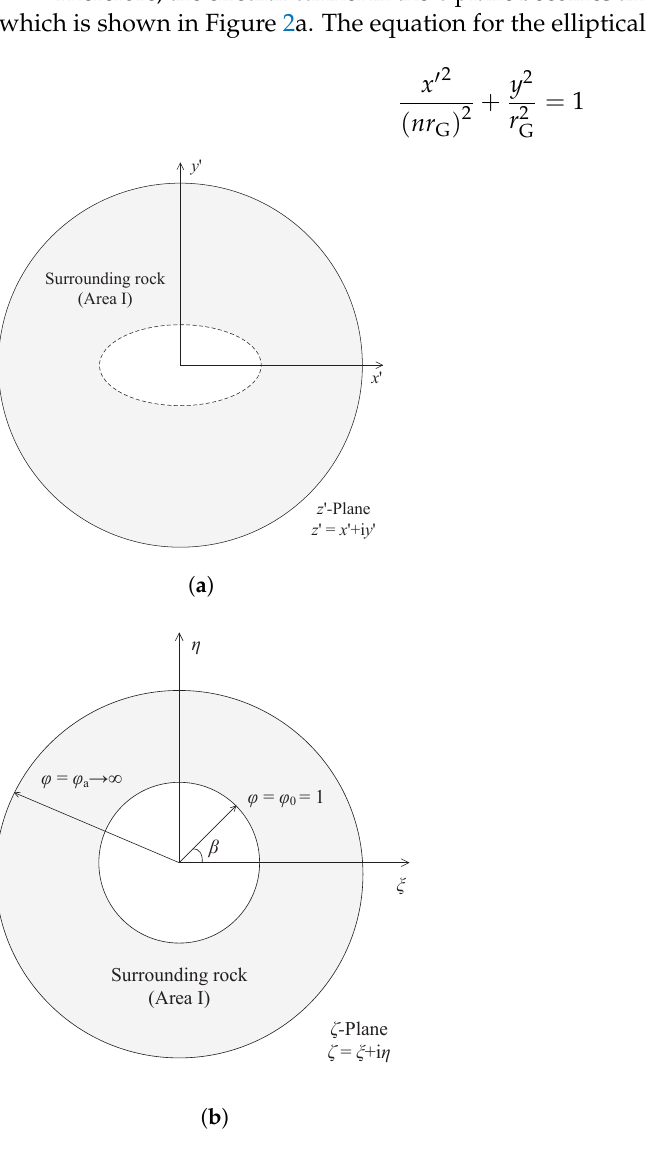
Figure 2. Calculation model after coordinate transformation and conformal mapping. ( a ) Plane of coordinate transformation. ( b ) Plane of conformal